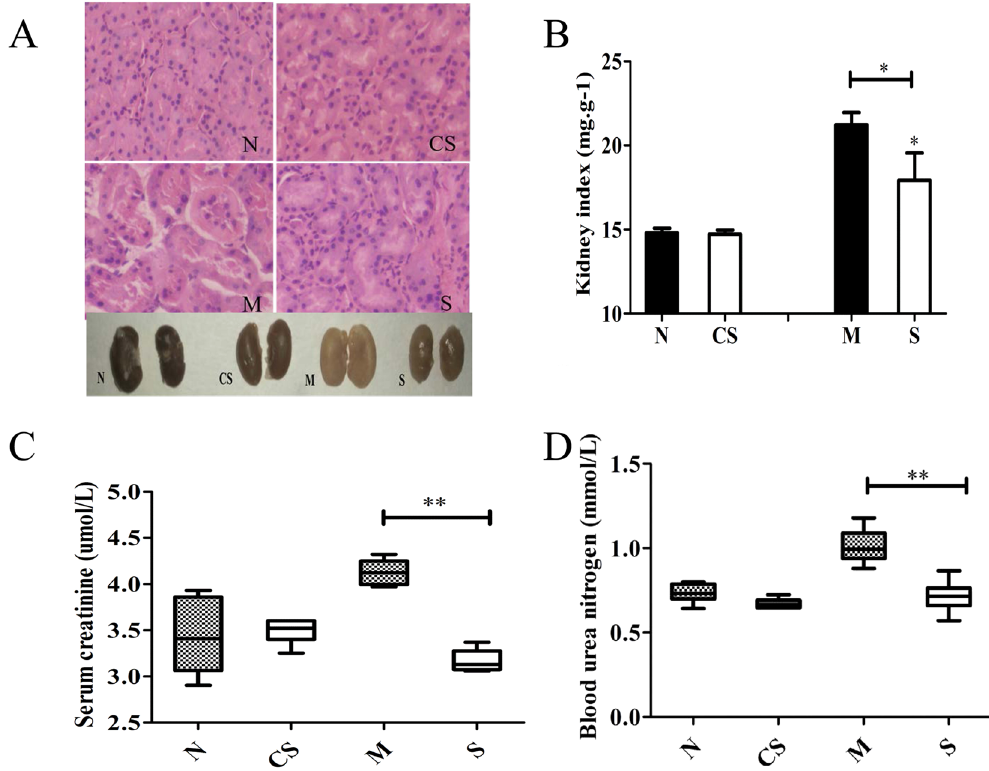
Figure 3. Kidney morphology and blood parameters. ( A ) Kidney morphology (the cortex, 40x); ( B ) Kidney index; ( C ) Serum creatinine levels. ( D ) Blood urea nitrogen levels. N: healthy mice + PBS; CS: healthy mice supplemented with a daily dose of 150 mg/kg bodyweight of CS disaccharides for 16 days; M: mice subjected to exhaustive exercise stress + PBS; S: the stressed mice supplemented with a daily dose of 150 mg/kg bodyweight of CS disaccharides for 16 days. * P < 0.05; ** P <